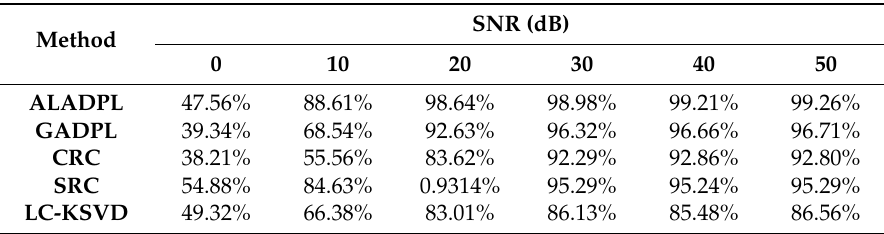
Table 5. Performance of the algorithm with different ENLs.